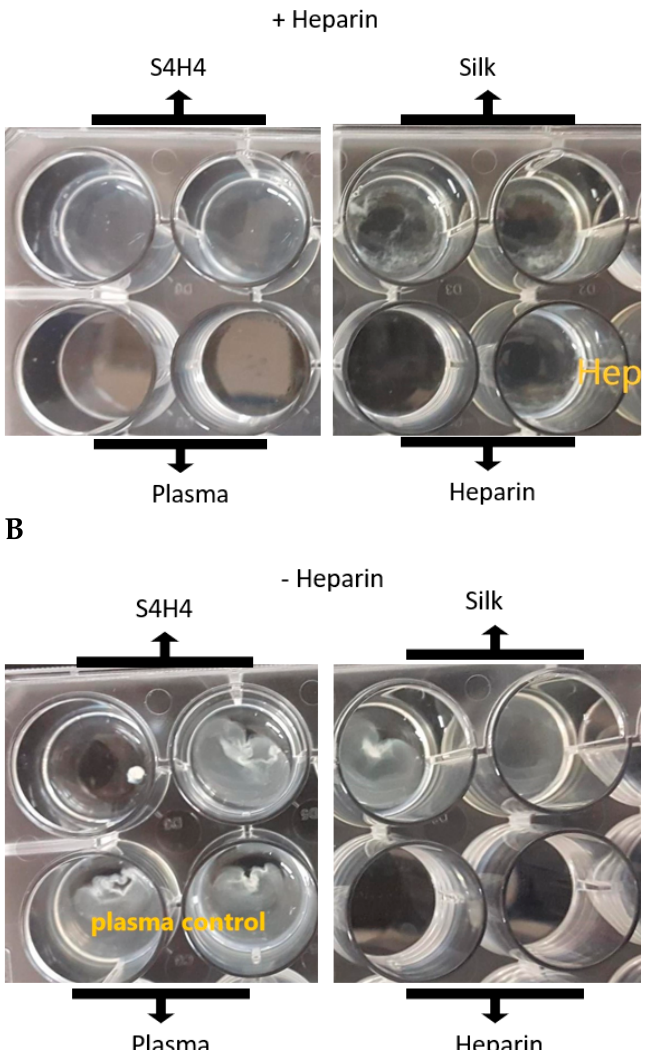
Figure 7. A visual representation of the aPTT coagulation assay endpoints. ( A ) heparin added to the assay produced noticeable lack of clotting in both S4H4 (top left) and the plasma control (bottom left) as anticipated by their ability to bind heparin, comparable to the heparinized controls (bottom right). The silk-coated surface shows evidence of clot-like formation (top right). ( B ) All wells lacking heparin produced a noted strong clotting response, in contrast to control heparinized wells (bottom right) (n =